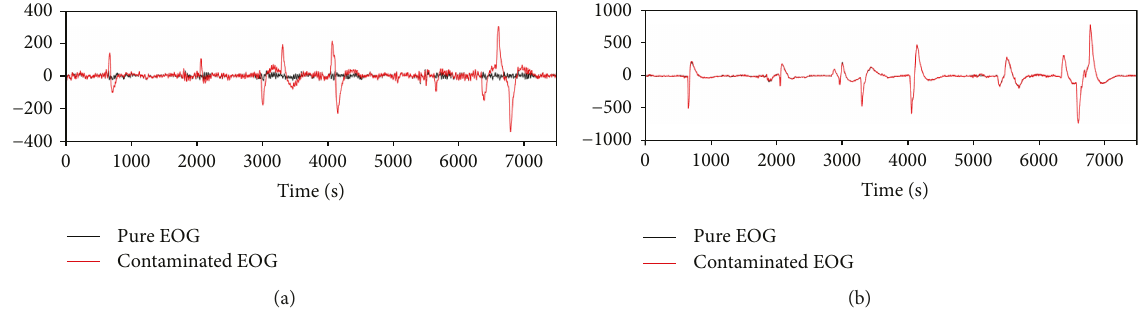
Figure 3: Example of simulated signals. (a) Simulated contaminated EEG signal. (b) Simulated contaminated EOG